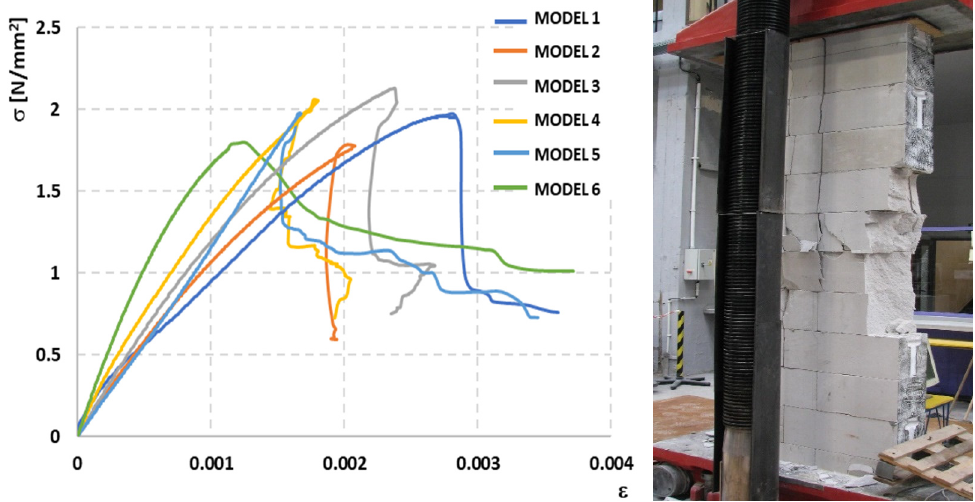
Figure 19. Stress-strain under compression relationship of masonry wall model made of autoclaved aerated concrete blocks under uniform load and view of an example element after the test.